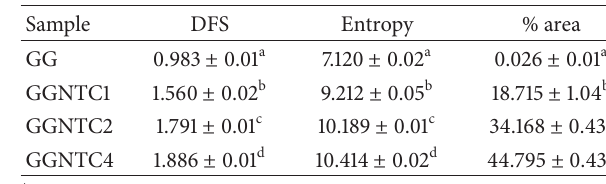
Table 3: Texture parameters obtained by image analysis of films from gelatin/glycerol and carbon nanotubes ∗